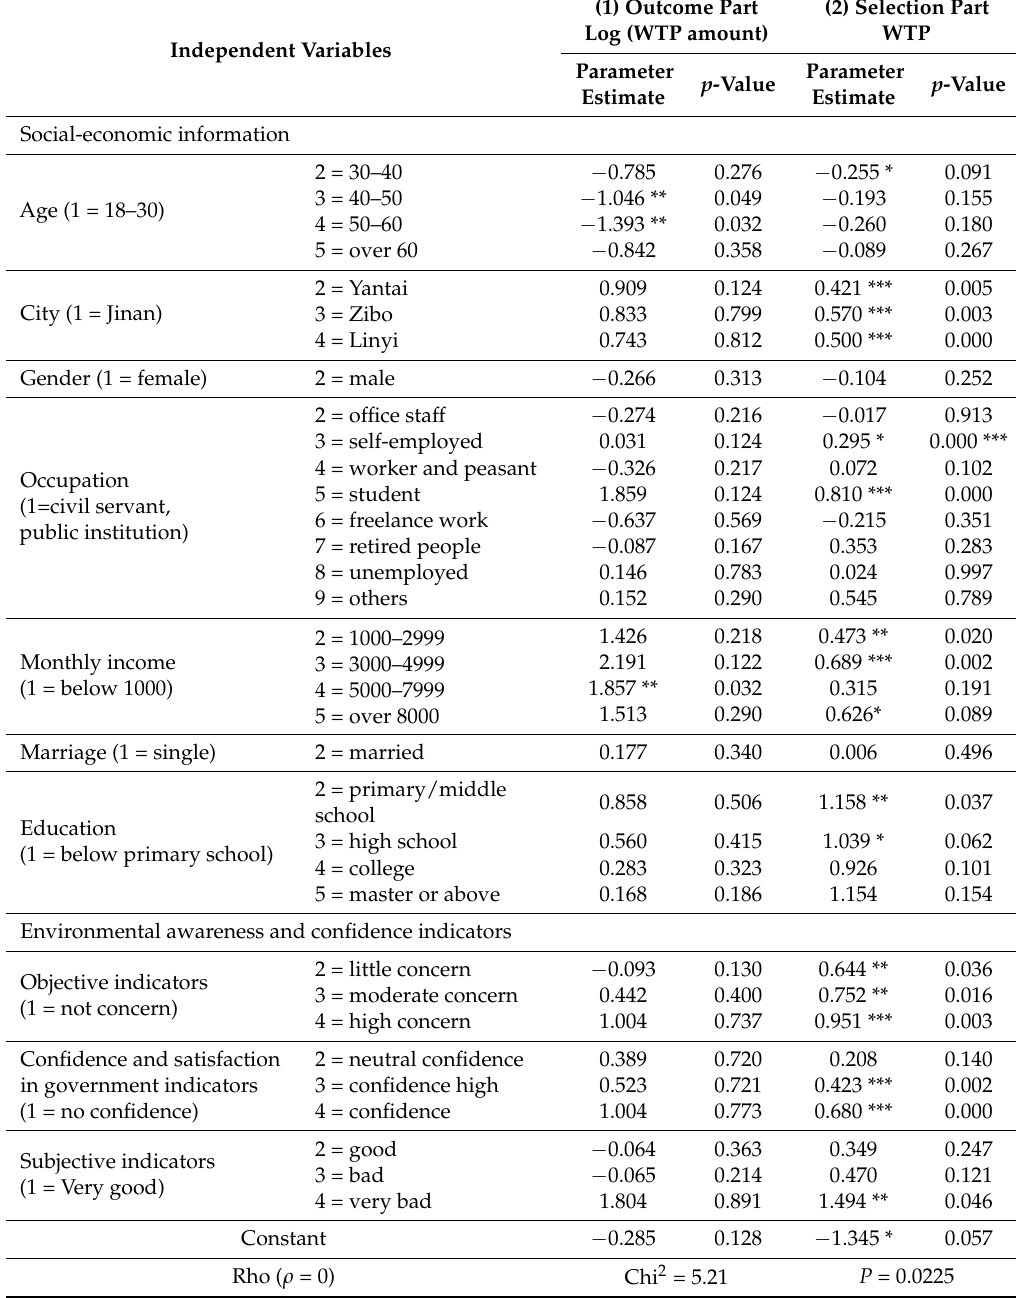
Table 5. Heckman sample selection model analysis ( N = 1006). (Wald Chi 2 = 70.37, P =